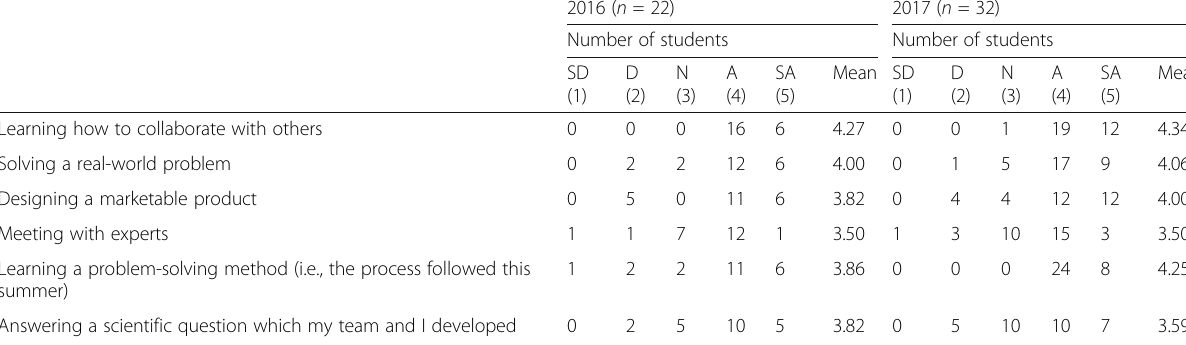
Table 3 Summer 2016 and 2017 electronic survey results — importance of components. Prompt 1: The following were important components to creating a valuable VIX experience